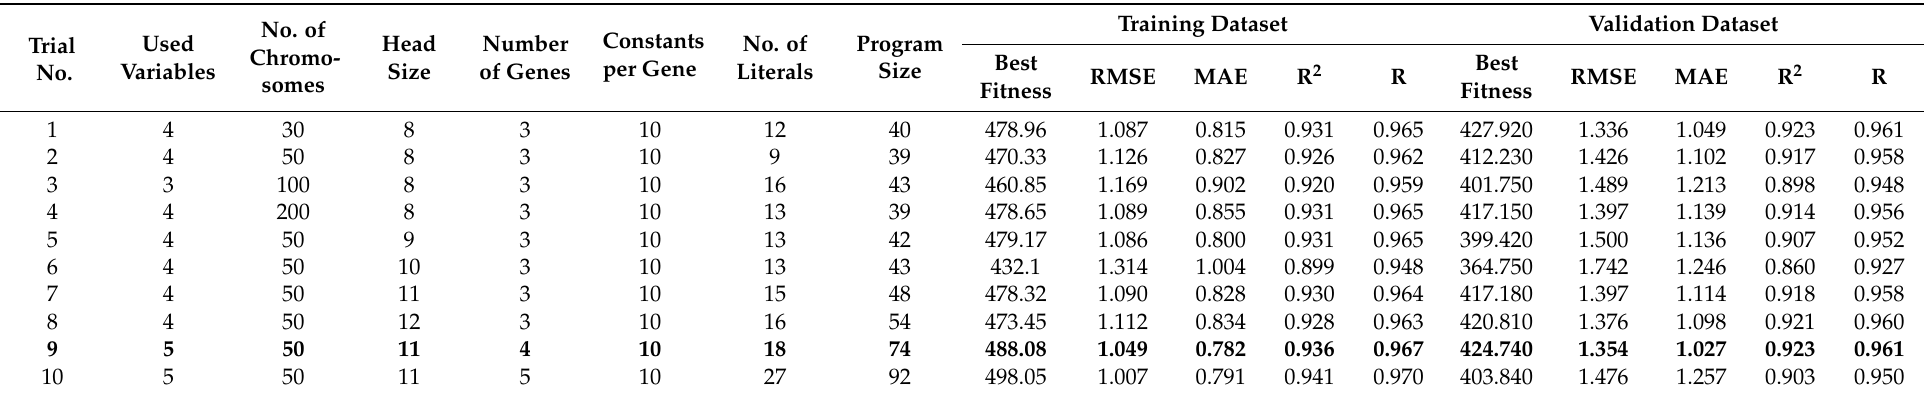
Table 2. Statistical evaluation of undertaken